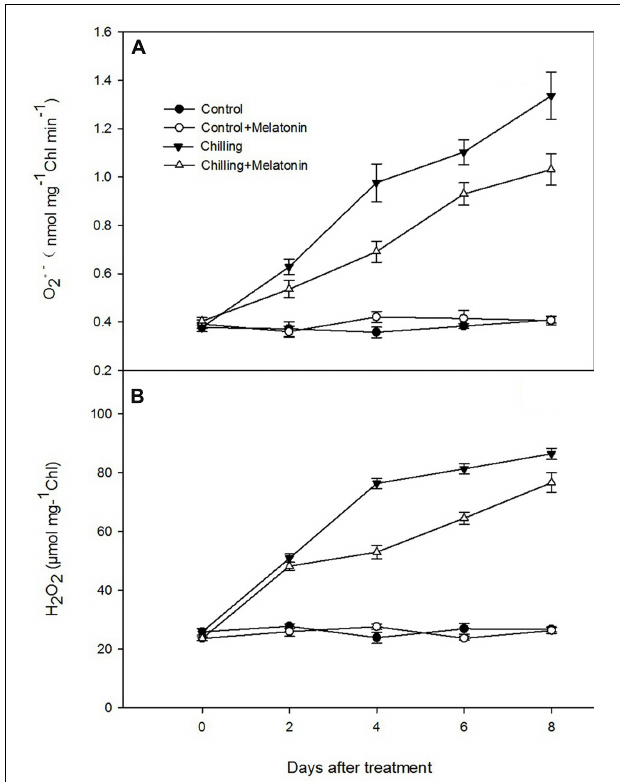
FIGURE 4 | Effects of exogenous melatonin on (A) superoxide anion (O 2 -) and (B) hydrogen peroxide (H 2 O 2 ) contents of chloroplasts under chilling stress. Control (28/18 ◦ C); Control + Melatonin (200 µ M melatonin, 28/18 ◦ C); Chilling (15/8 ◦ C); Chilling + Melatonin (200 µ M melatonin, 15/8 ◦ C). Data are means ± SD of three